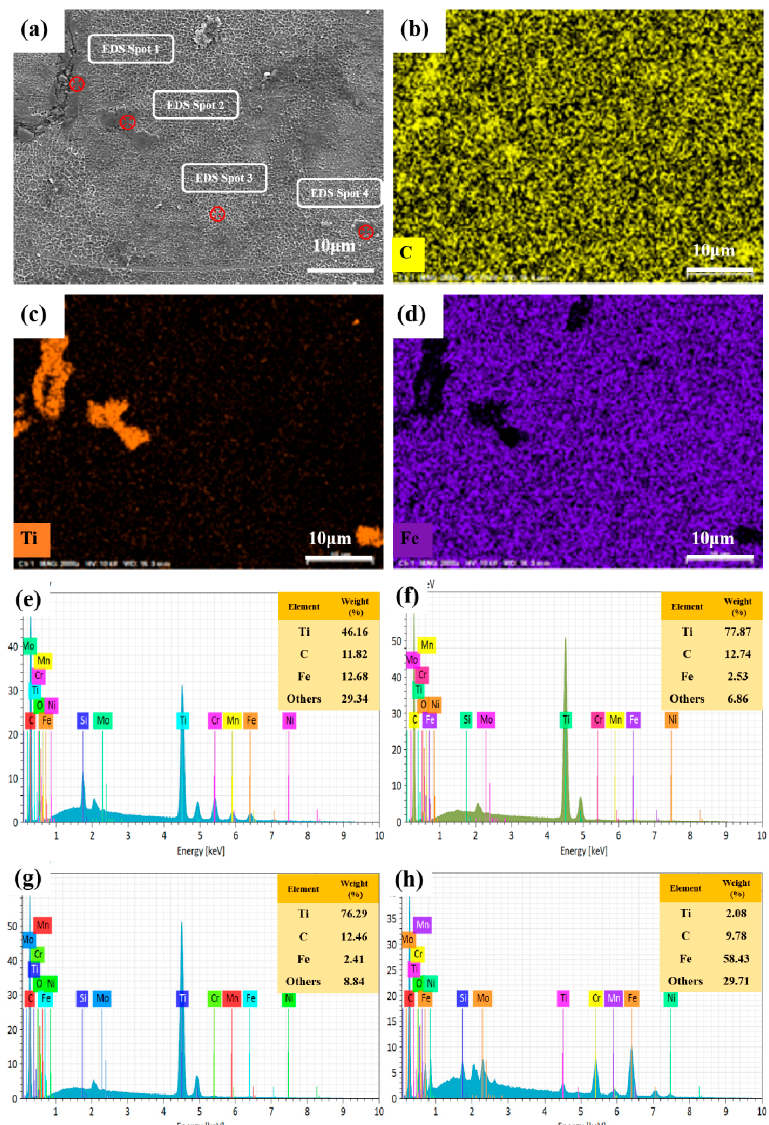
Figure 1. ( a ) SEM images of the TiC/316L stainless steel composites formed by SLM. EDS mapping of the ( b ) C element in ( a ); ( c ) Ti element in ( a ); and ( d ) Fe element in ( a ). Energy-dispersive X-ray spectral (EDS) spot analysis of ( e ) Spot 1; ( f ) Spot 2; ( g ) Spot 3 and ( h ) Spot 4.